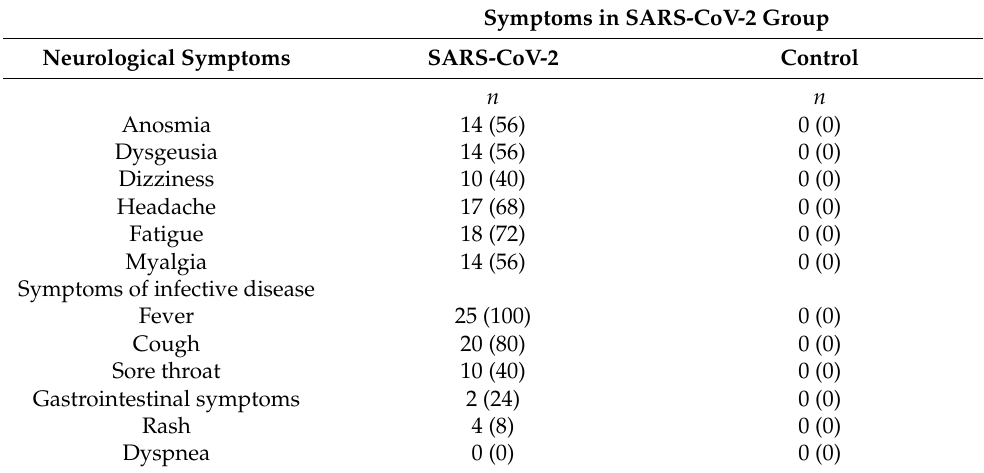
Table 4. The frequency of nonspecific neurological and general symptoms in subjects who had mild form of SARS-CoV-2 infection.